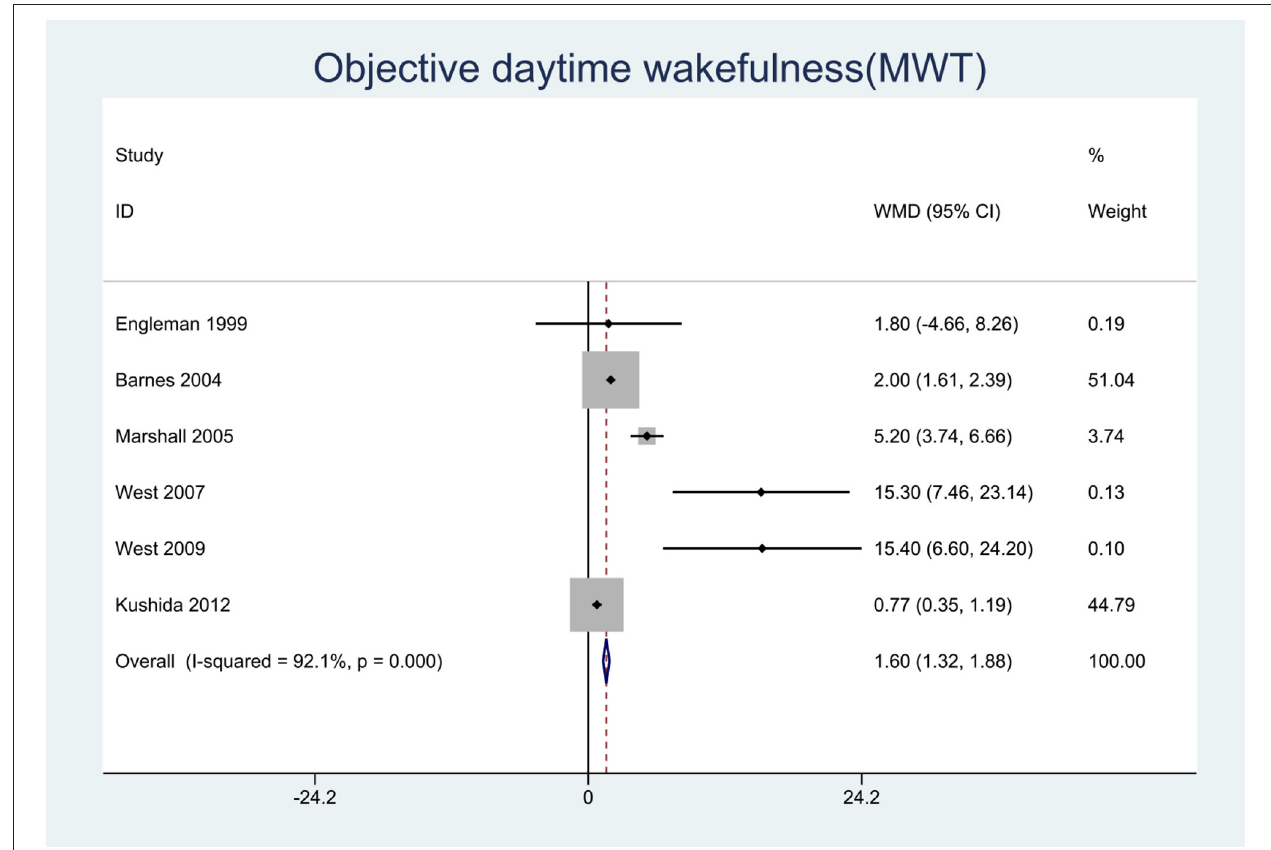
FIGURE 4 | Forest plot showing pooled weighted mean difference (WMD) for Maintenance of Wakefulness Test (MWT) in studies on continuous positive airway pressure (CPAP), compared with control group.